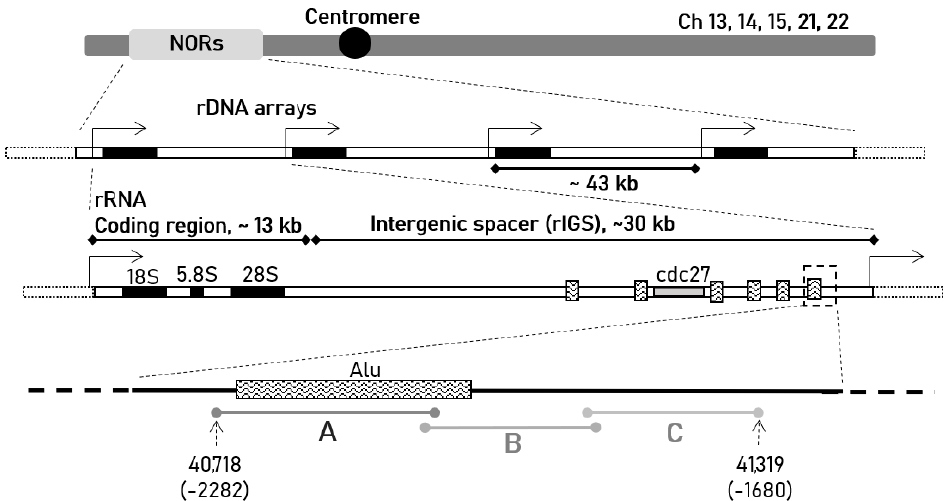
Figure 1. The schematic representation of human rDNA arrays located in the nucleolar-organizing regions (NORs) on short arms of acrocentric chromosomes, each containing ~13 kb coding region for 18S, 5.8S and 28S rRNAs, and ~30 kb ribosomal intergenic spacer (rIGS). Features in the rIGS such as Alu-repeats and cdc27 pseudogene are schematically represented based on the available data [15]. The region under investigation in the current work is located ~2 kb upstream of the rDNA transcription start site (black arrows) and highlighted by dotted-line arrows indicating the positions of nucleotides (according to GenBank sequence U13369.1, https://www.ncbi.nlm.nih.gov/nuccore/555853 accessed on 1 June 2021). A, B and C segments represent the primer pairs designed to analyze transcriptional activity of the corresponding zone. The sequences are given in the Table A1.